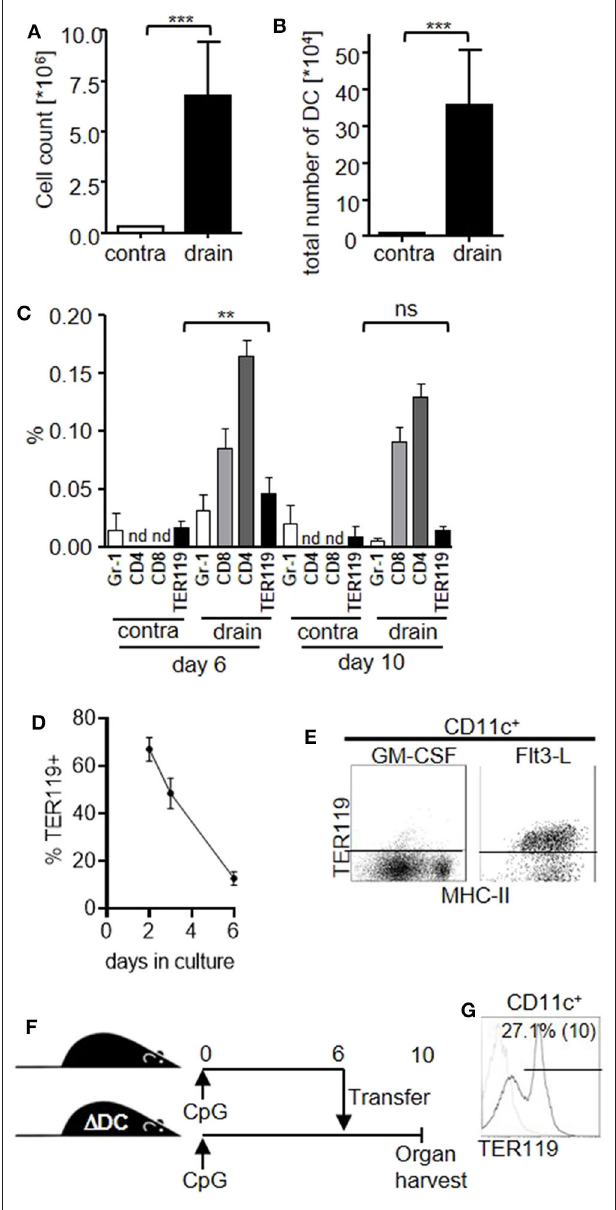
FIGURE 3 | TER119 + CD11c high cells contribute to the DC compartment in the draining lymph node upon local inflammation. (A–C) Mice were injected with a single dose of CpG-ODN into one footpad. Graphs show (A) cell count of the contralateral (contra) and draining (drain) lymph nodes at day 10 post stimulation, (B) total number of DC in lymph nodes, (C) proportion of B220 − CD11c + CD11b high Gr-1 + (Gr-1), CD4 + , CD8 + and TER119 + CD11c + DC subsets in the lymph nodes at day 6 and day 10 post stimulation. nd = not examined. Representative data of at least 3 experiments with n = 5 animals/group are shown. (D,E) TER119 + CD11a + splenocytes from CpG-ODN treated mice were cultured with GM-CSF or FLT3-L. (D) Graph shows proportion of TER119 + cells in culture with GM-CSF at the indicated time points. (E) Representative blots showing TER119 and MHC-II expression on CD11c + cells after culture with Flt3-L. (F) Experimental setup for the adoptive transfer of TER119 + CD11a + splenocytes from congenic wt mice into CpG-ODN–stimulated mice that are deficient for DC ( 1 DC). (G) Donor-derived